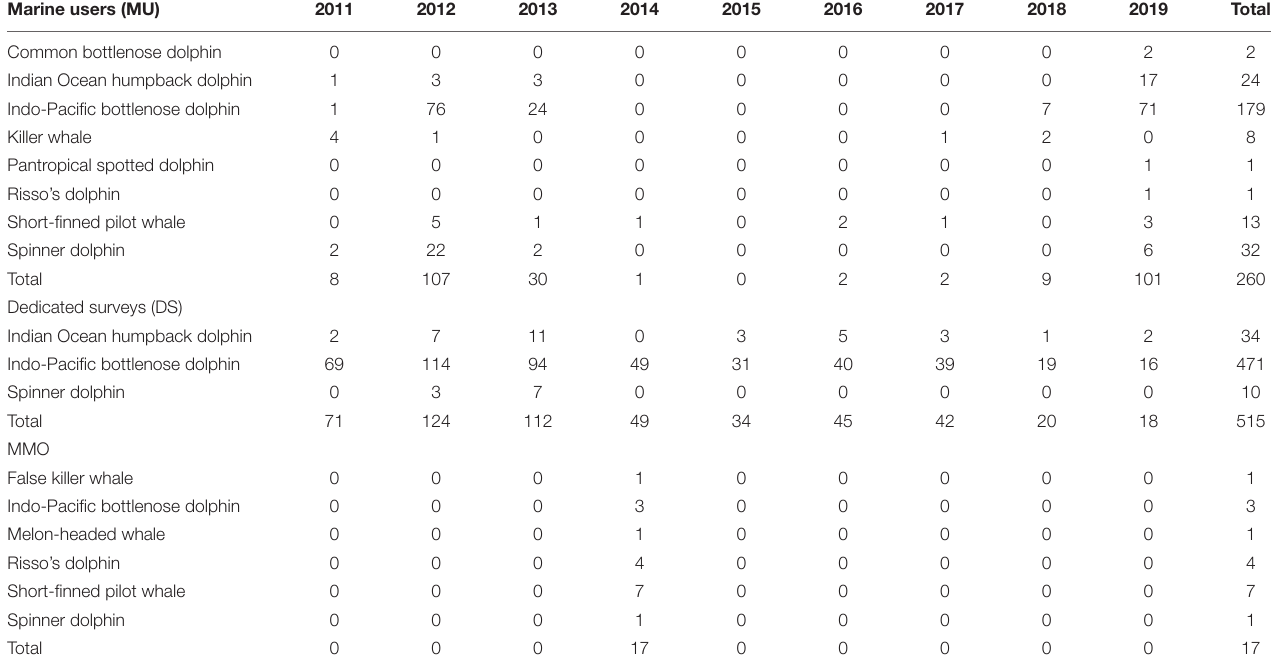
TABLE 1 | Species sightings recorded by data collection method in the period